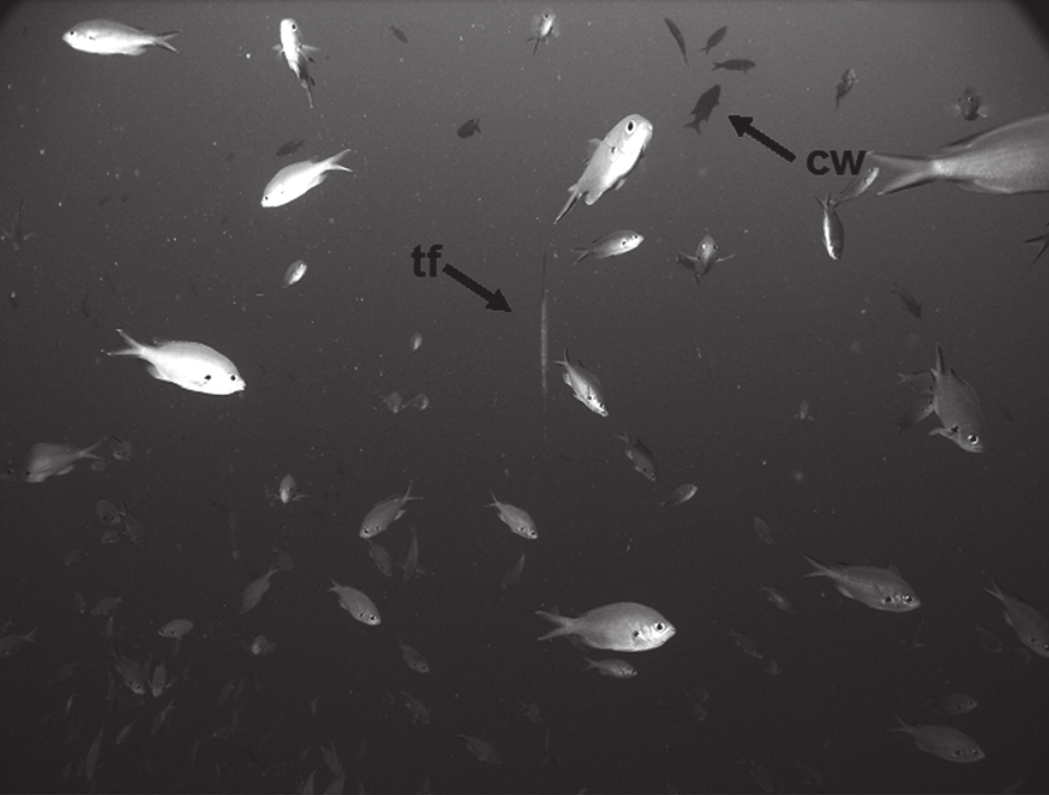
Fig. 1. A trumpetfish (“tf” at center arrow) hovering vertically above a feeding aggregation of brown chromis in order to stalk and ambush prey. Note the aggregation of Creole wrasse (cw)